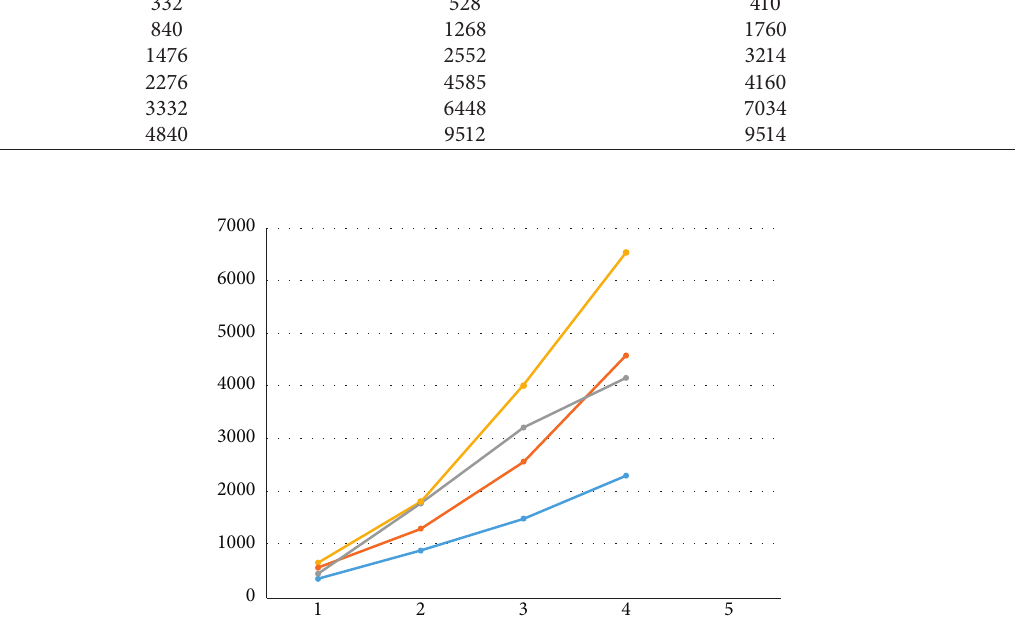
H H H H H , H , H , and H are represented by 1 + S 2 1 + R 2 1 + Q 2 1 + T 2